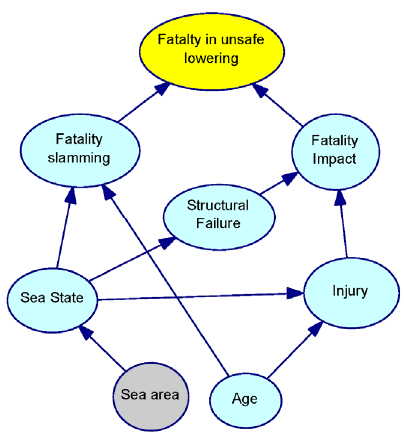
Figure A9. A Bayesian network for survival at sea in both flooding and fire/explosion accidents (08).